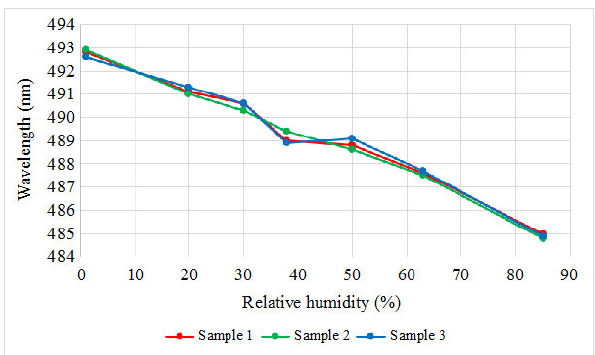
Fig. 8 RH level versus RLS peak